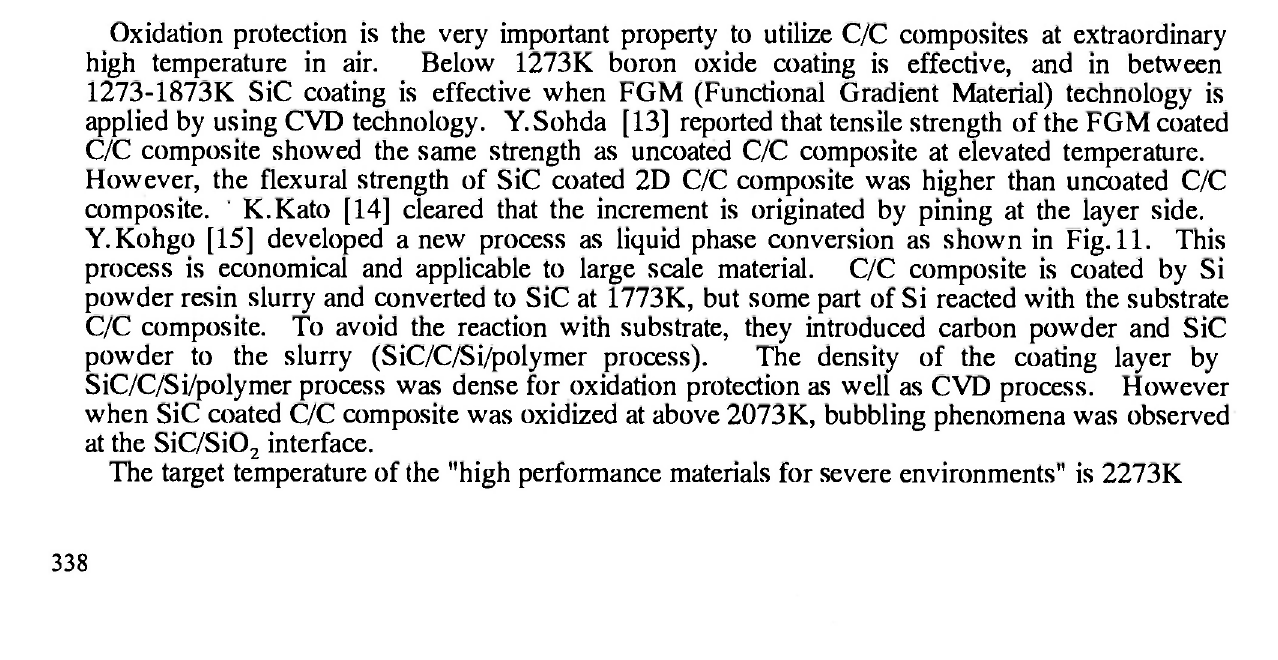
Fig. 9 Effect of HTT on thermal conductivity of pitch based UD C/C composite.